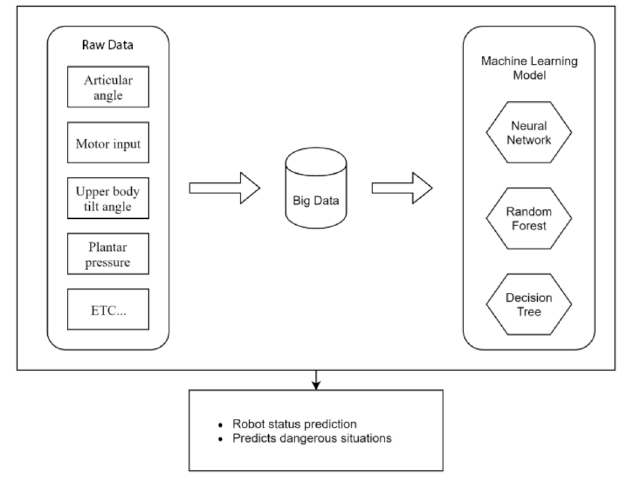
Figure 8. Schematic of the machine-learning model of the status-prediction module.